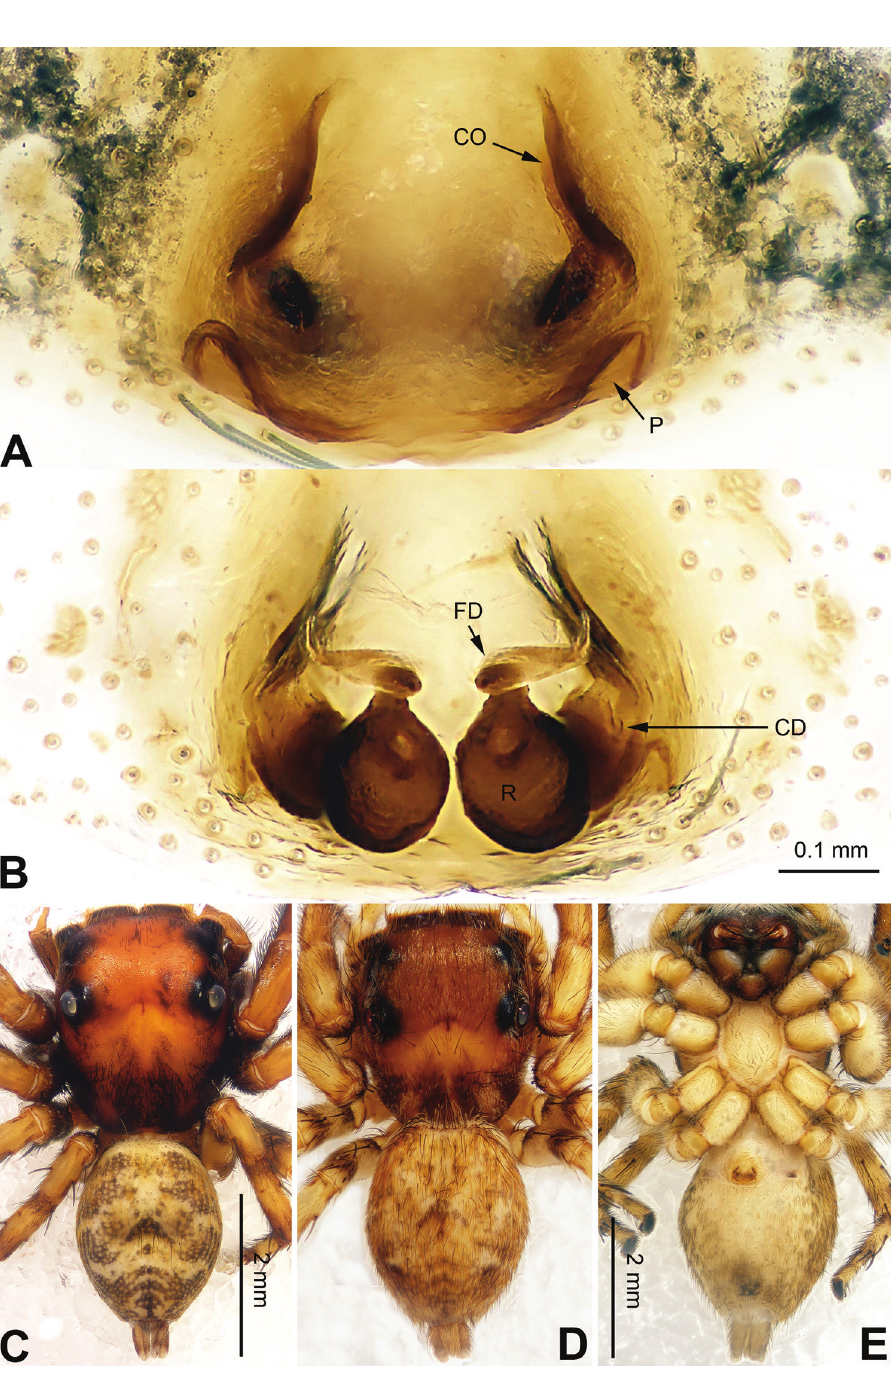
Figure 10. Carrhotus kevinlii sp. n., female paratype and male holotype. A epigyne, ventral B vulva, dorsal C male habitus, dorsal D female habitus, dorsal E female habitus, ventral. Scale bars equal for A and B ; equal for D and